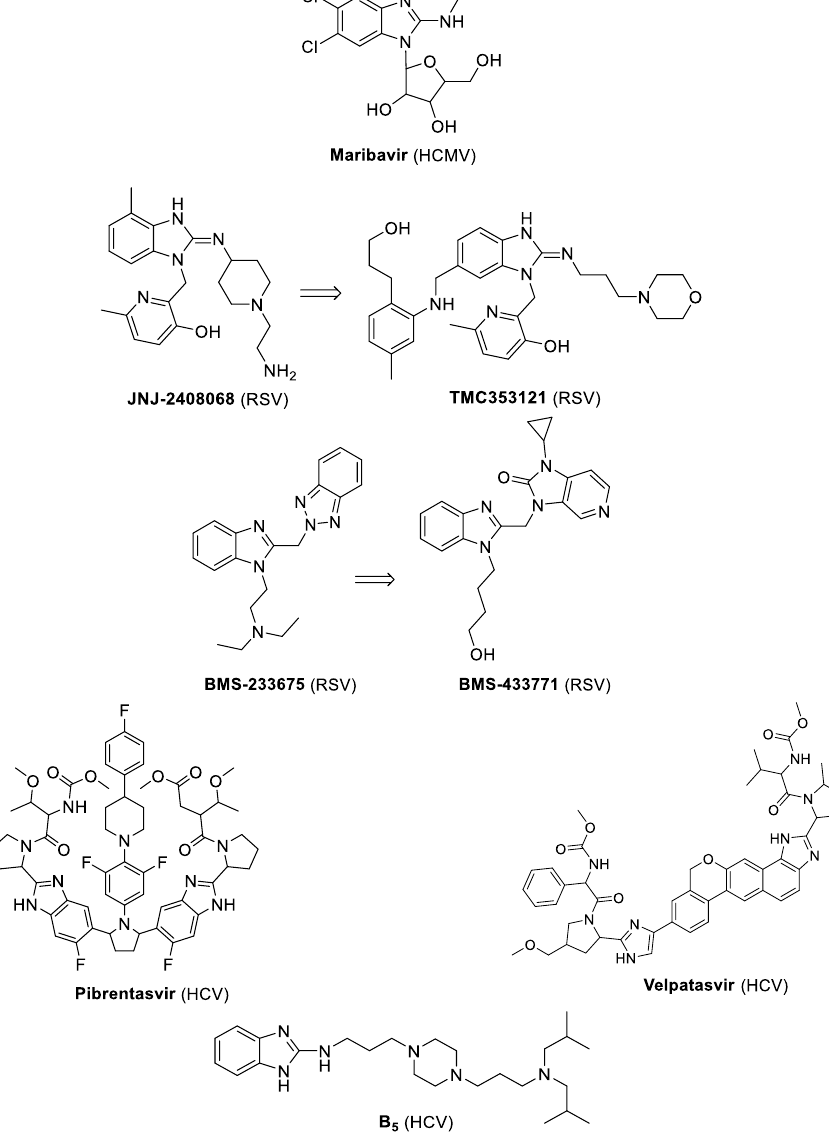
Figure 1. Some prototypic benzimidazole derivatives with activity against distinct viruses (mentioned between brackets).